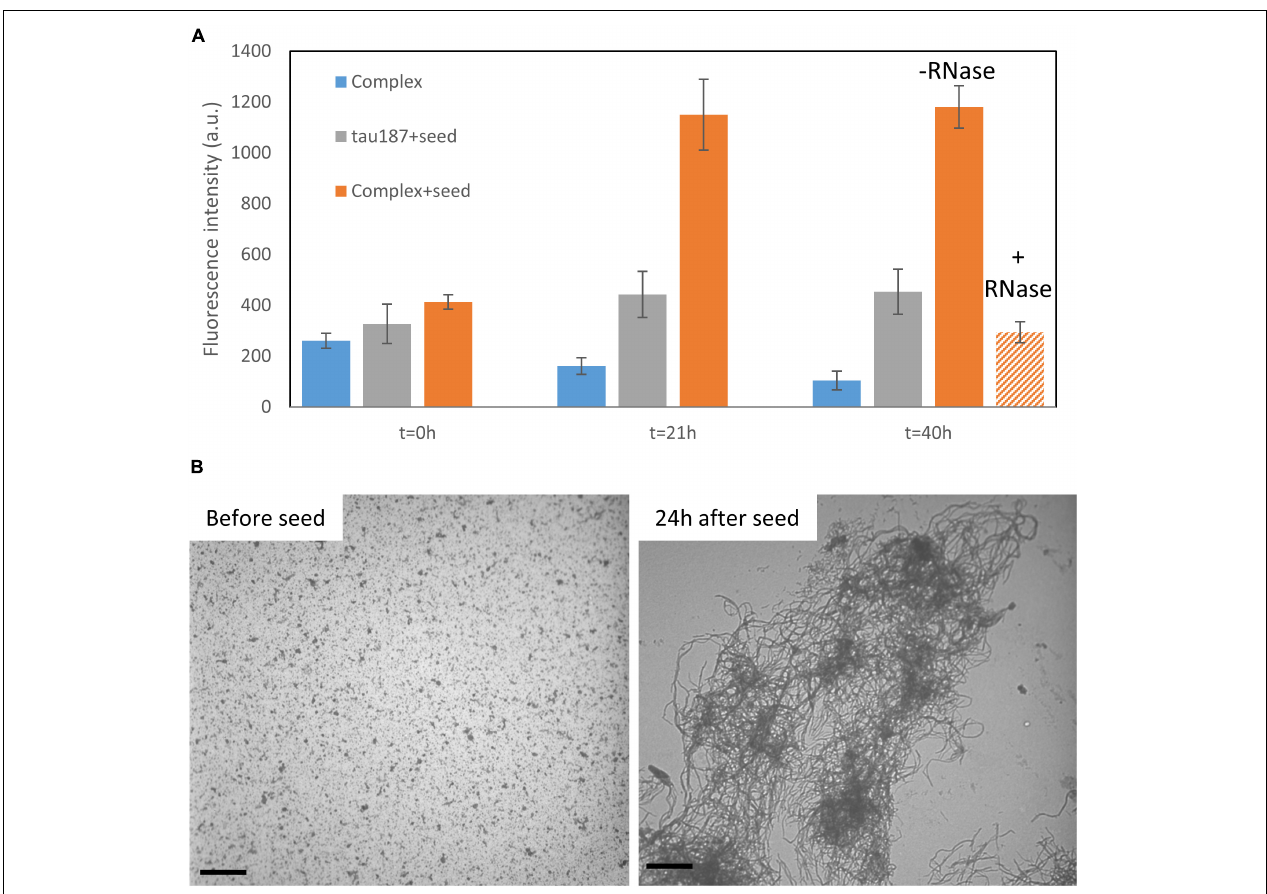
FIGURE 7 | Tau187-polyU complex is stable but can be converted to ThT active species in the presence of a seed. (A) ThT intensity of the complex sample eluted from a Ni-affinity column with (orange) or without 5% seed (blue). In comparison, fresh tau187 is incubated with seed (gray). The seed is added at time t = 0 h and the ThT value, reported at 21 h, increased significantly for the seeded complex. RNase is added right after 21 h and significantly reduces the ThT intensity. Full kinetics curves are shown in Supplementary Figure S18 . (B) TEM pictures show tau187-polyU complexes (without Ni-affinity purification) that are converted to fibrillary assemblies 24 h after seed addition. Scale bars are 1 µ